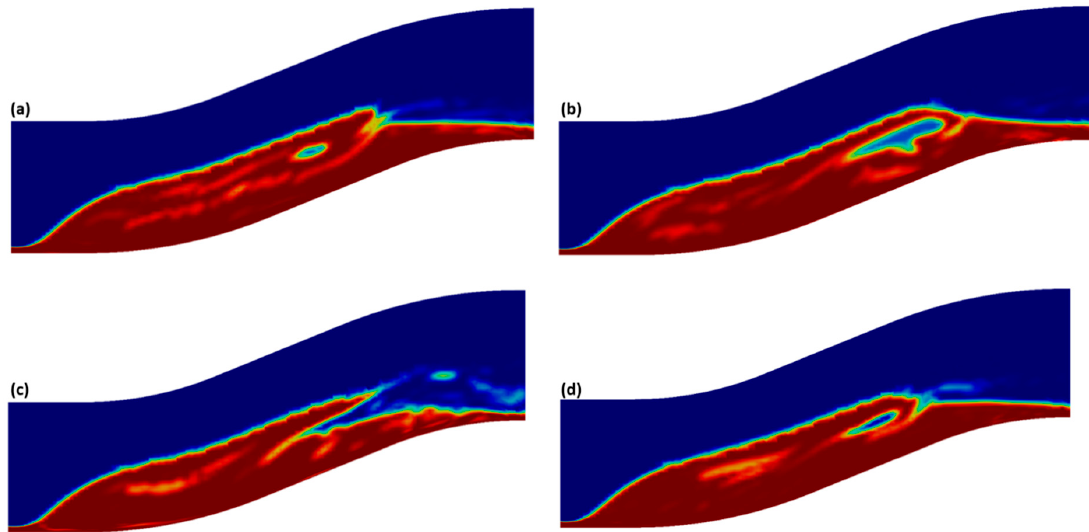
Figure 7. Liquid volume fraction (i.e. red corresponds to liquid and blue to gas) at the swan neck for case 5 (i.e. U G = 4.61 m/s), for four di ff erent timesteps spaced by 10s between them. We see that gas penetrates the gas-liquid interface and forms a bubble that gradually increases in size and eventually bursts. ( a ) t = 130 s; ( b ) t = 140 s; ( c ) t = 150 s; ( d ) t = 160 s.